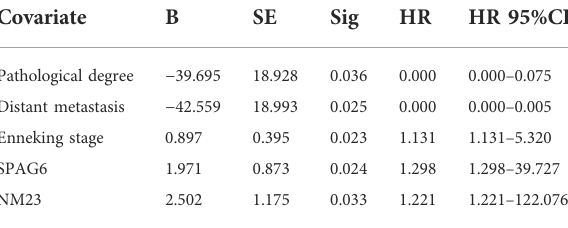
TABLE 3 Multivariate survival analysis of 42 patients with osteosarcoma. Covariate B SE Sig HR HR 95%CI Pathological degree −